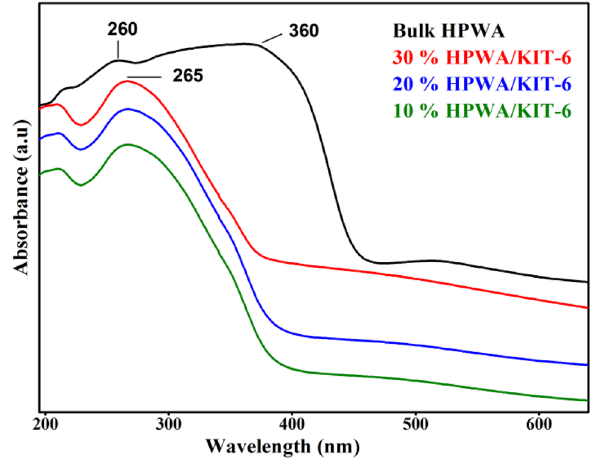
Fig. 6 HR-SEM images with EDAX spectrum of HPWA-sup- ported catalysts. a 10% HPWA/ KIT-6, b 20% HPWA/KIT-6 with EDAX spectrum, c